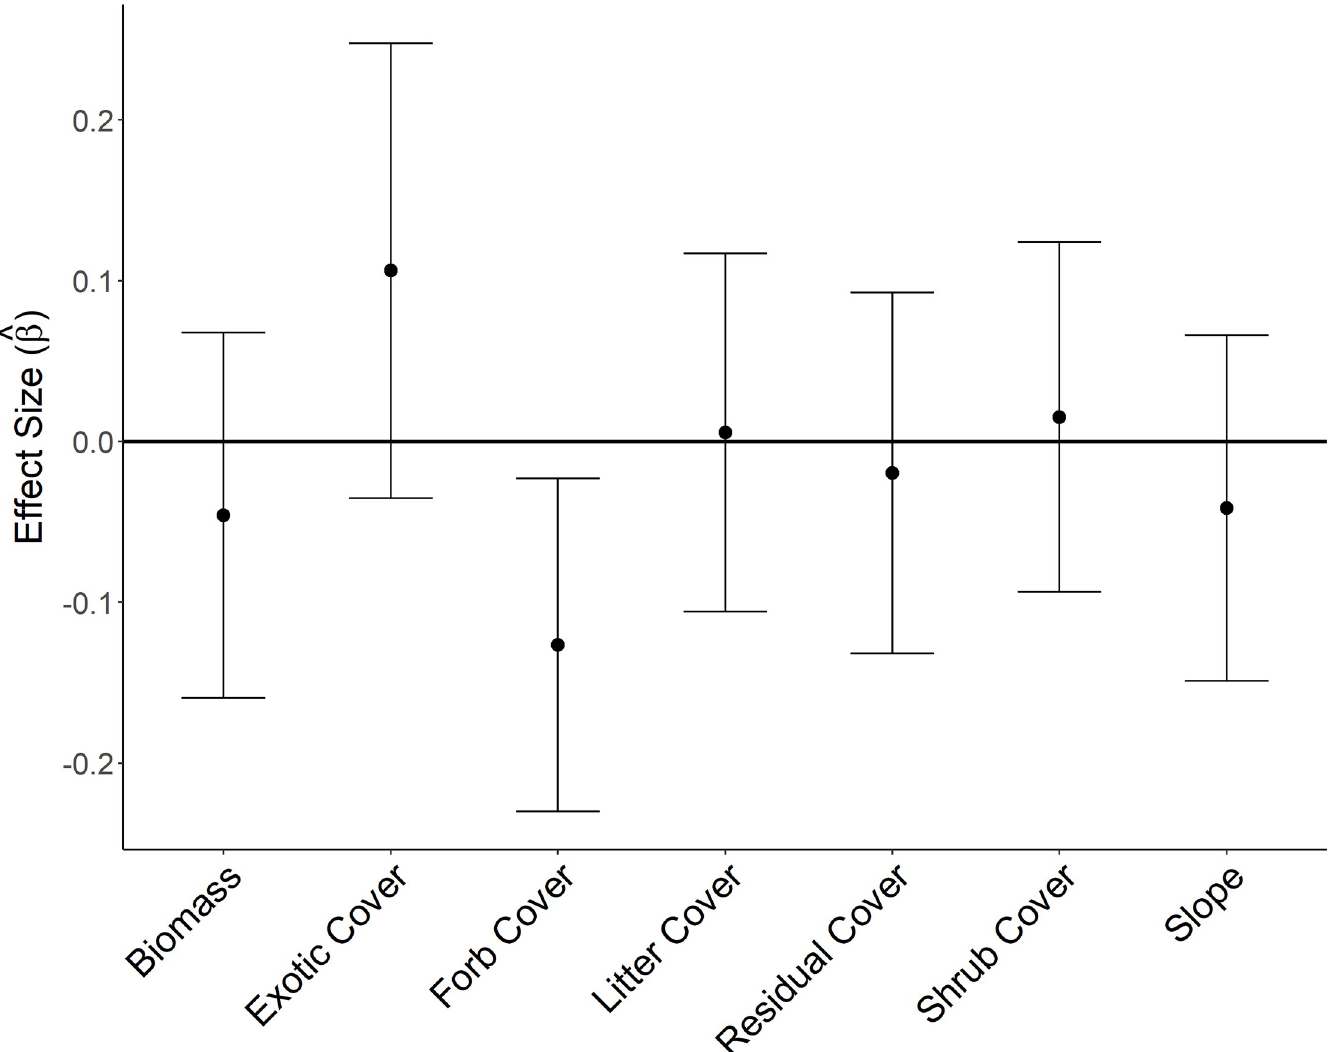
Fig 3. Estimated effect sizes of nest site features on survival of chestnut-collared longspur nests. Estimated effect sizes and 95% confidence intervals from standardized covariates measured at the nest site on daily survival of 263 chestnut-collared longspur nests in 100 9-ha plots in Phillips County, MT, during May–July of 2017 and